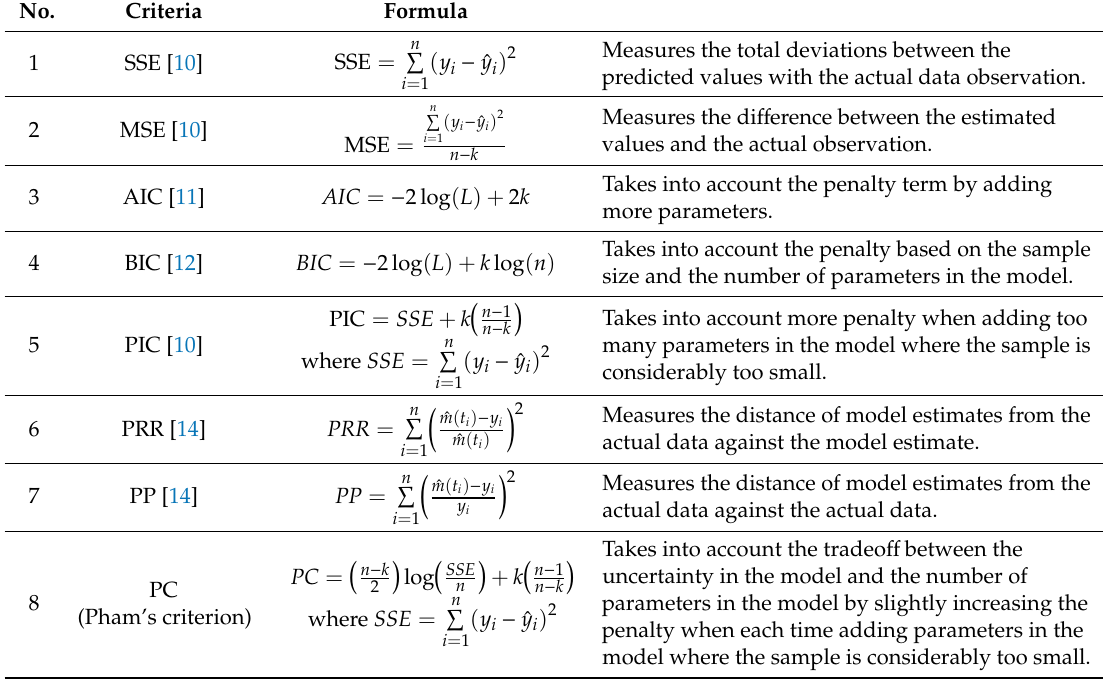
Table 2. Some criteria model